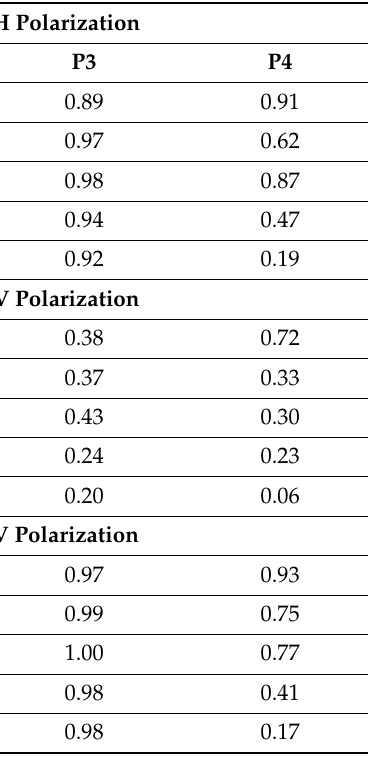
Table 2. Comparison of coherence from L-band ALOS-2 image pairs generated from different polarizations with different acquisition intervals starting from 17 January 2019 (interferogram pairs were formed by cross-multiplying the image of 17 January 2019 with the subsequent